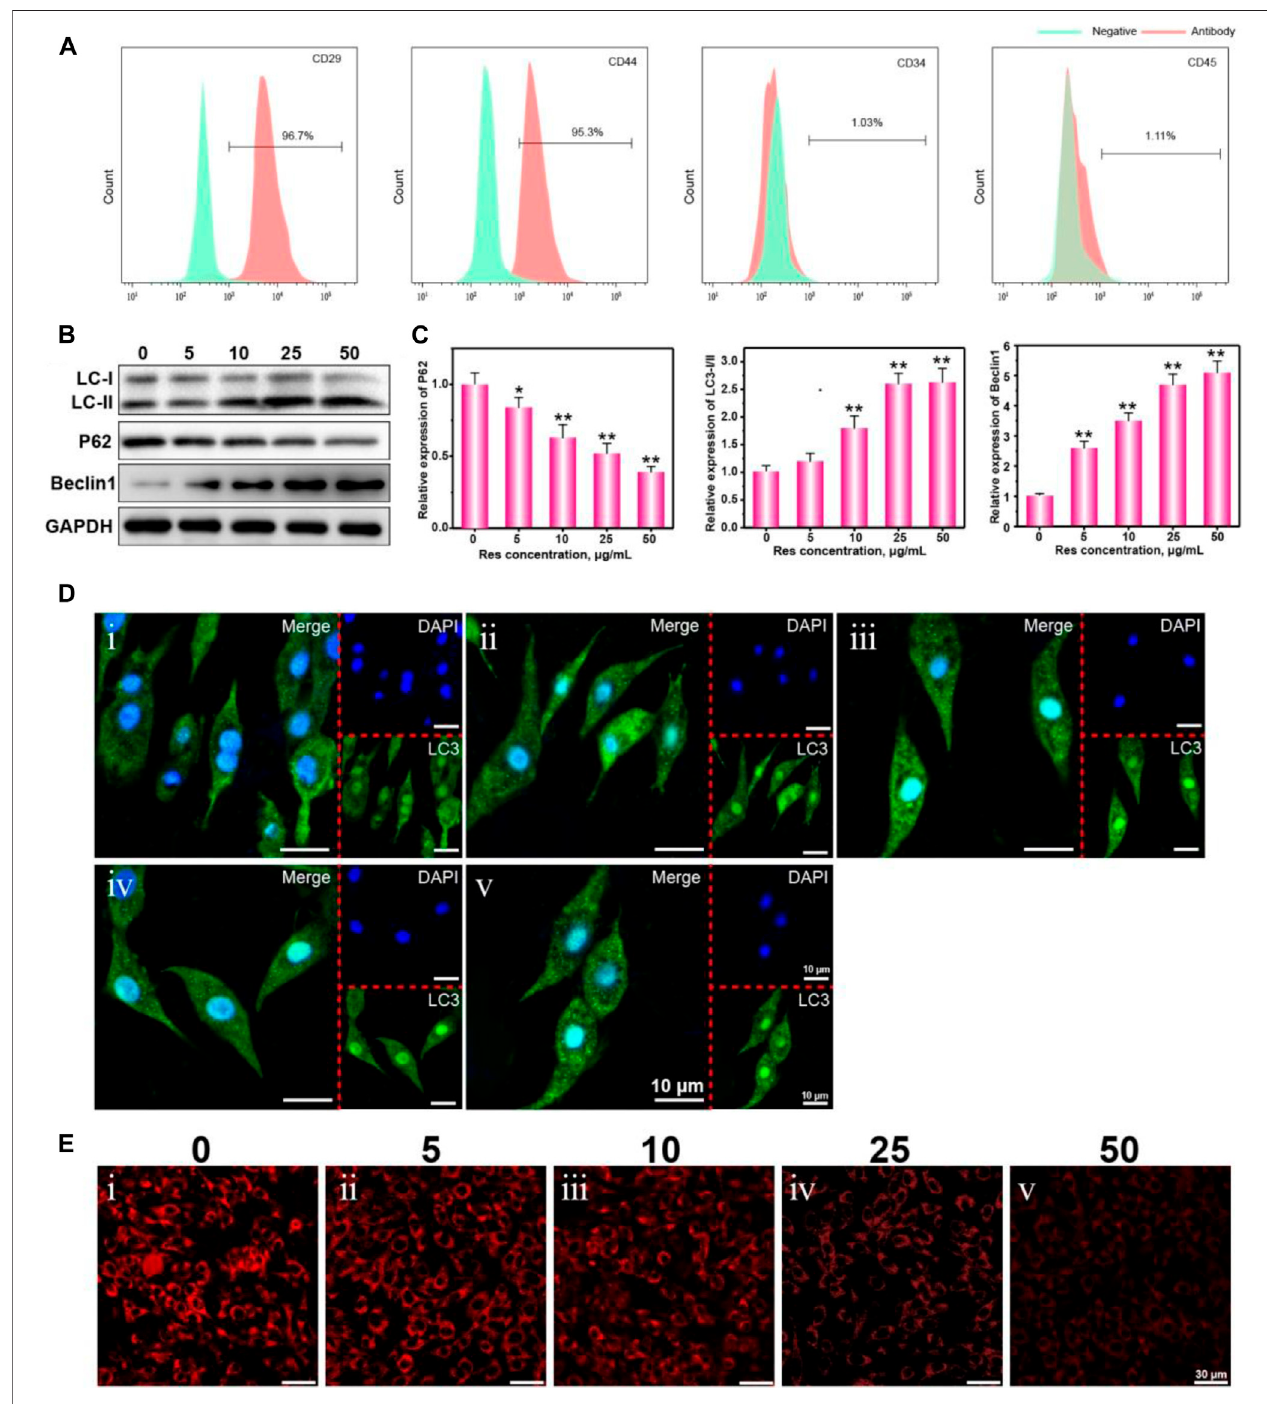
FIGURE1| Thegrowthmorphology (A) ,cellviability (B) ,real-timecellgrowthcurve (C) ,WBofKi67 (D) ,andstatisticalanalysis (E) ofBMSCstreatedwithResor3- MA. The values are represented as the mean ± SD ( n (cid:1) 3). * p < 0.05, ** p < 0.01 vs control (without Res and 3-MA).